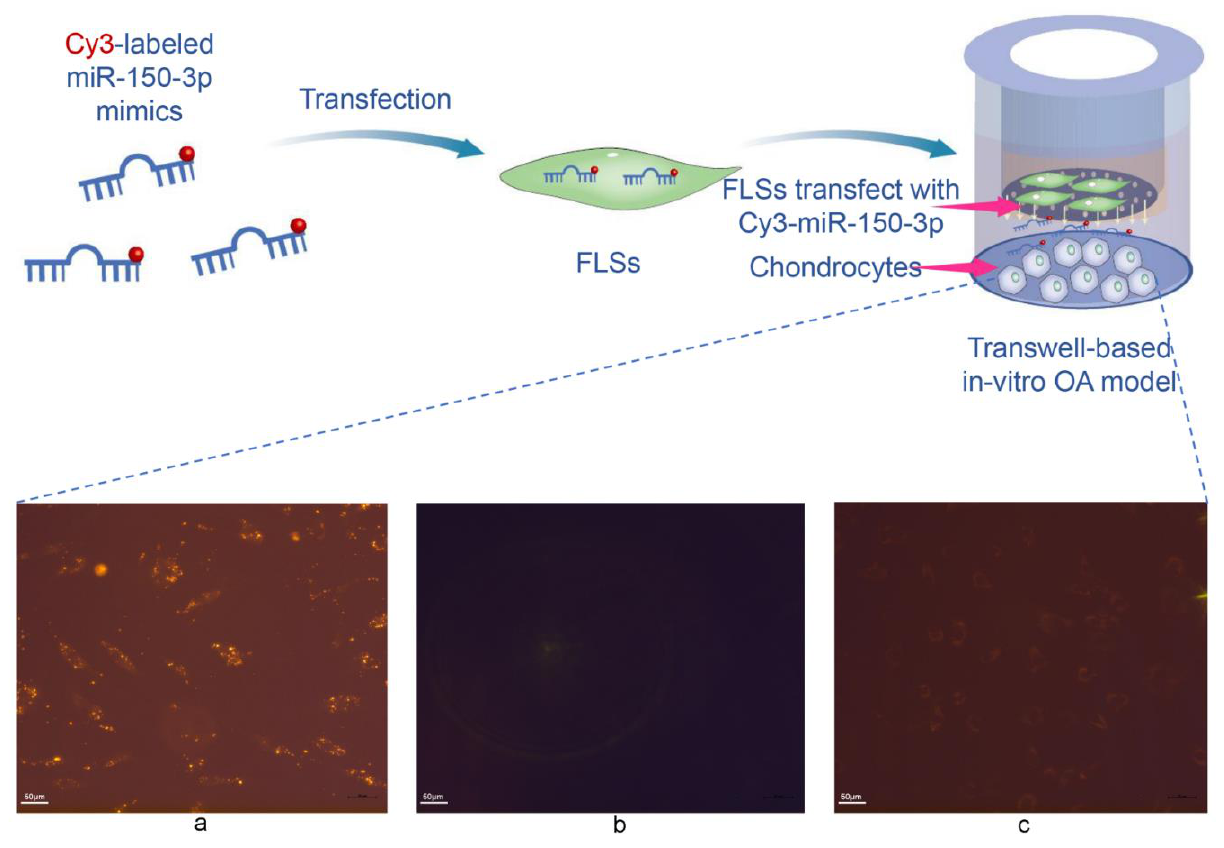
Figure 6. The ability of exosomes to transport miRNAs. miRNA transport in the transwell-based in vitro OA model. ( a ) FLSs were transfected with a miR-150-3p mimic labeled with Cy3 (red fluorescence) and co-cultured with chondrocytes. ( b ) FLSs were treated with Cy3 alone. ( c ) GW4869 inhibition of EV formation.